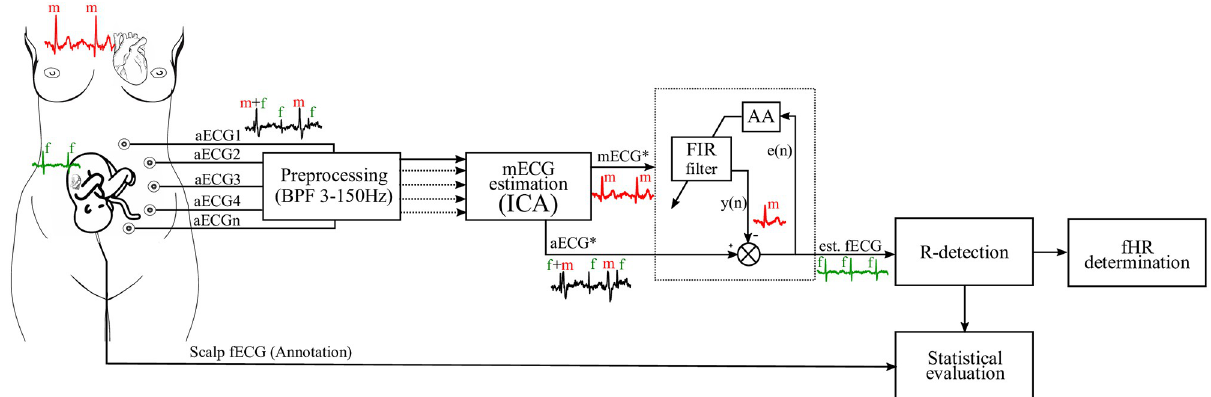
Fig 1. A simplified block diagram of the hybrid system. First block consists of ICA method and provides maternal reference signal ( mECG � ) and primary input ( aECG � ) with suppressed maternal and enhanced fetal component; second block consists of the adaptive block with adaptive algorithm (AA) which estimates the fECG